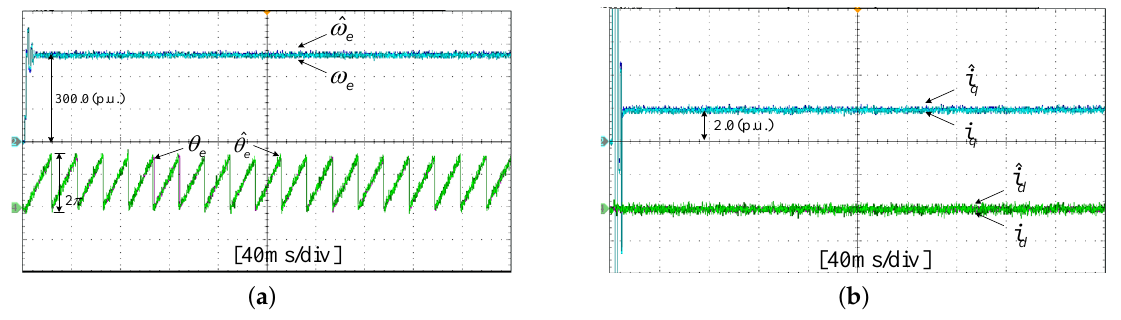
Figure 27. Experimental results of states and their estimated values. ( a ) States ω e , θ e and their estimated values ˆ ω e , ˆ θ e ; ( b ) states i d , i q and their estimated values ˆ i d , ˆ i q .